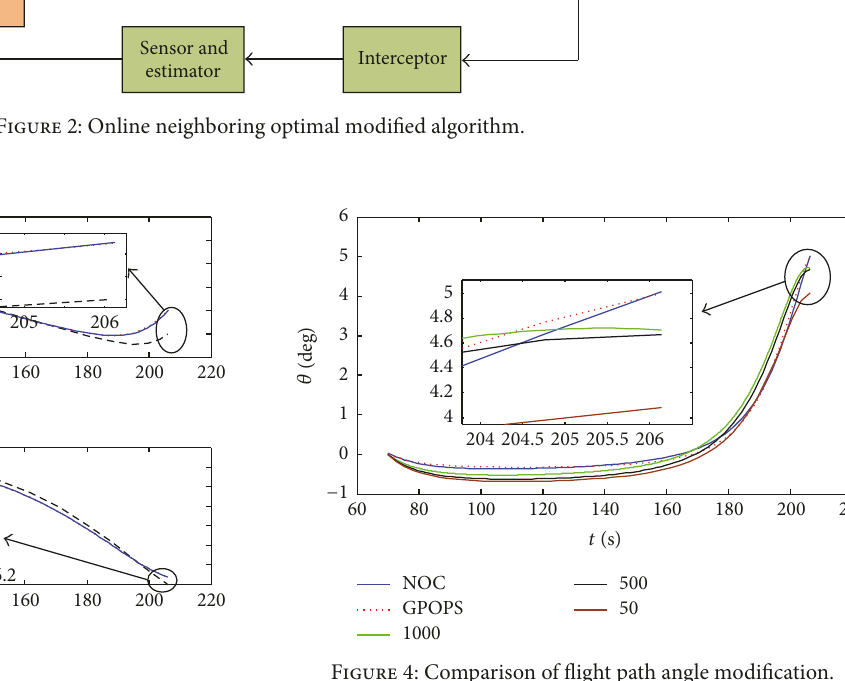
Figure 4: Comparison of flight path angle